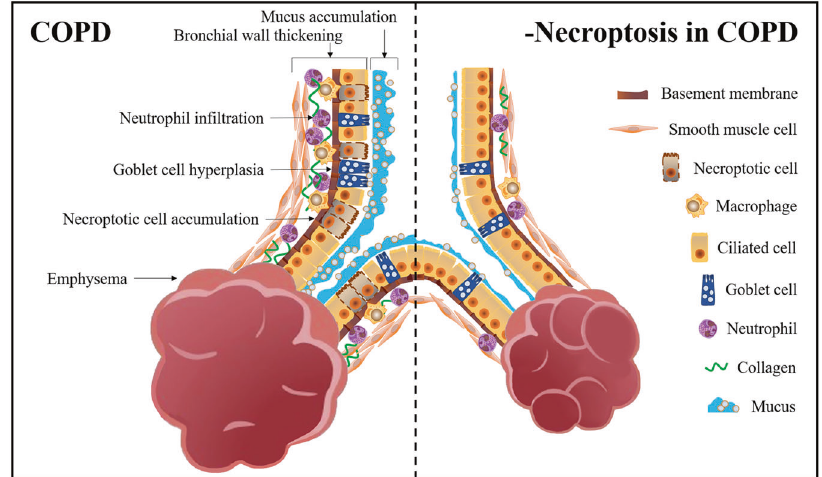
Fig. 2 Pathological changes after inhibiting necroptosis in COPD. The left side of the dashed line shows the pathological manifestations of air fl ow limitation in COPD, including small-airway disease and emphysema; the right side shows the pathological changes after inhibiting necroptosis in COPD, the speci fi c as follows: in the small airway, the increased number of ciliated cells, the reduced thickness of the bronchial wall, and the improvements of neutrophilic airway in fl ammation, mucus accumulation and collagen deposition; in the alveoli, the improvements of alveolar lumen enlargement and alveolar wall